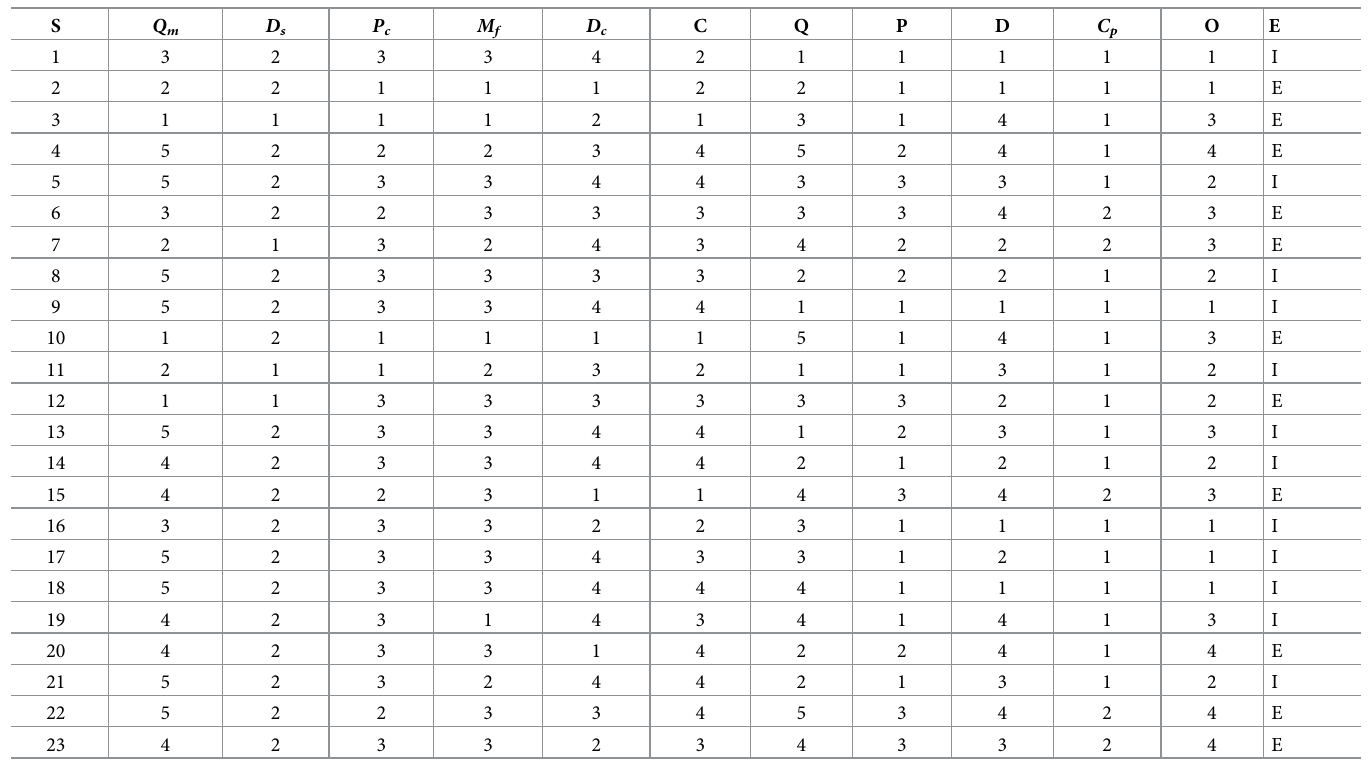
Table 10. Discretized supply base management data set.